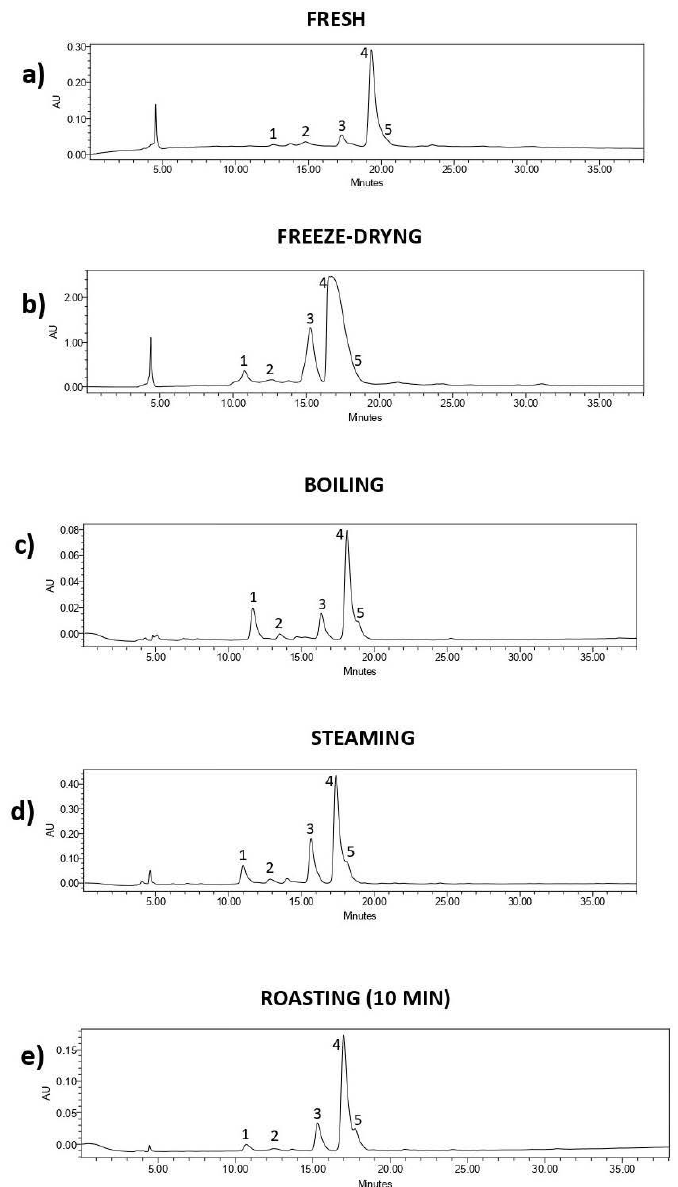
Figure 2. HPLC chromatogram of the purple carrots cooked by different methods recorded at 520 nm ( a – e ). Anthocyanin identification: 1. Cyanidin 3-xylosylglucosylgalactoside, 2. Cyanidin 3-xylosylgalactoside, 3. Sinapic acid derivative of cyanidin 3-xylosylglucosylgalactoside, 4. Ferulic acid derivative of cyanidin 3-xylosylglucosylgalactoside, 5. Coumaric acid derivative of cyanidin 3-xylosylglucosylgalactoside. Table 4 indicates the AA in terms of free radical scavenging activity measured